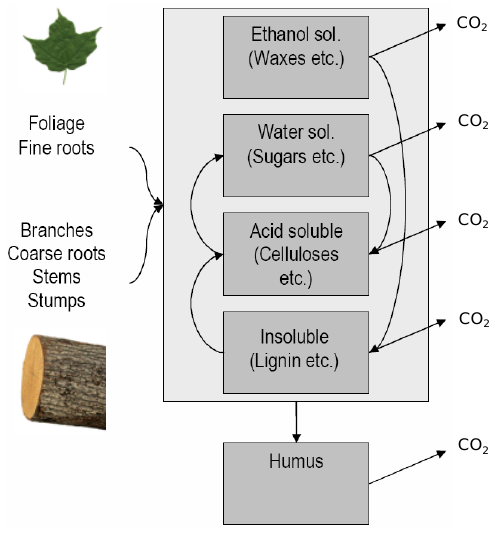
Fig. 3. Flow chart of Yasso07 model. The boxes represent carbon compartments and the arrows are carbon fluxes among compart- ments, into (litter input to the soil) or out of compartments (CO 2 release by decomposition).